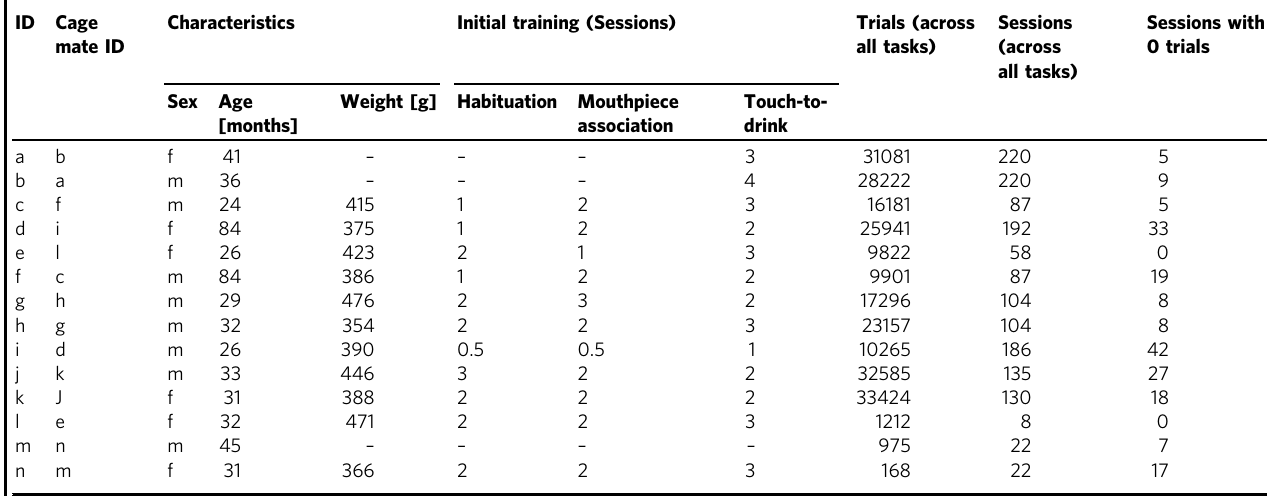
Table 1 Characteristics and statistics of all animals involved in the experiments.